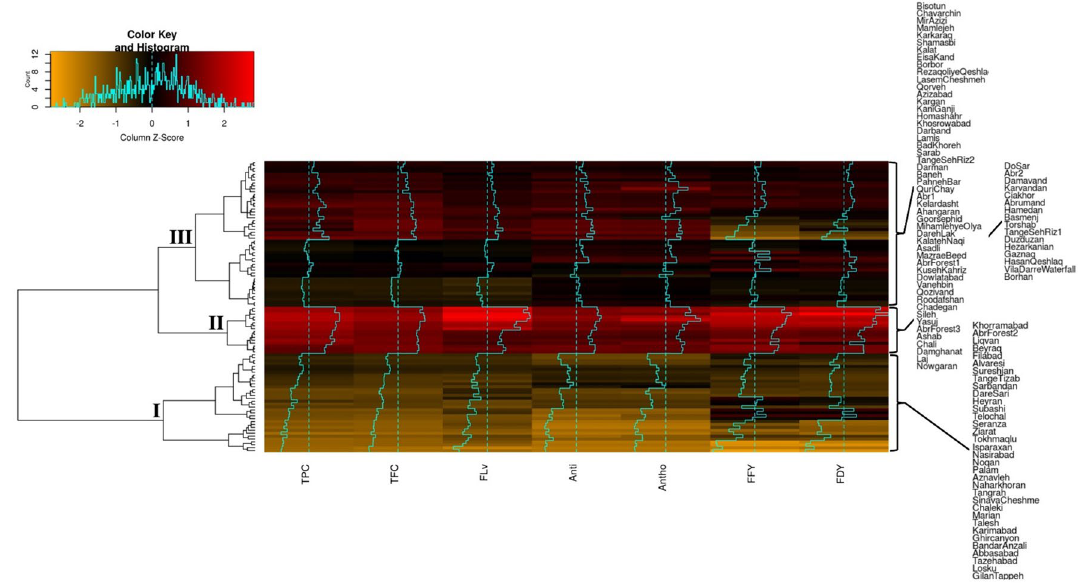
Figure 6. Heat-map and two-dimensional dendrogram for 100 Poa pratensis accessions tested for polyphenols content, antioxidant activity and forage yield traits in drought stress. Dendrogram illustrates the relation between accessions (rows) and traits (columns) based on variations in color shades obtained using Z-score. TPC, TFC, FLv, Anti, Antho, FFY and FDY represent vectors of total phenol content, total flavonoid